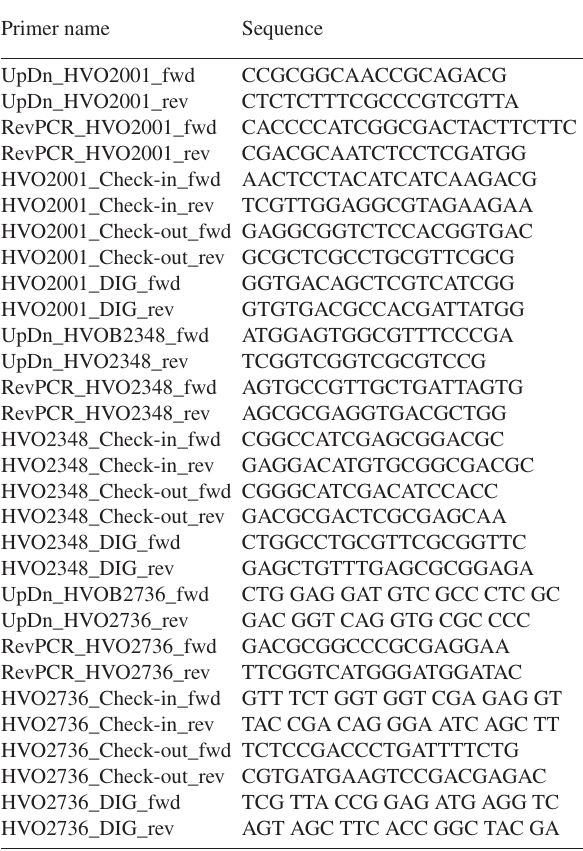
Table 2. List of primers used in this